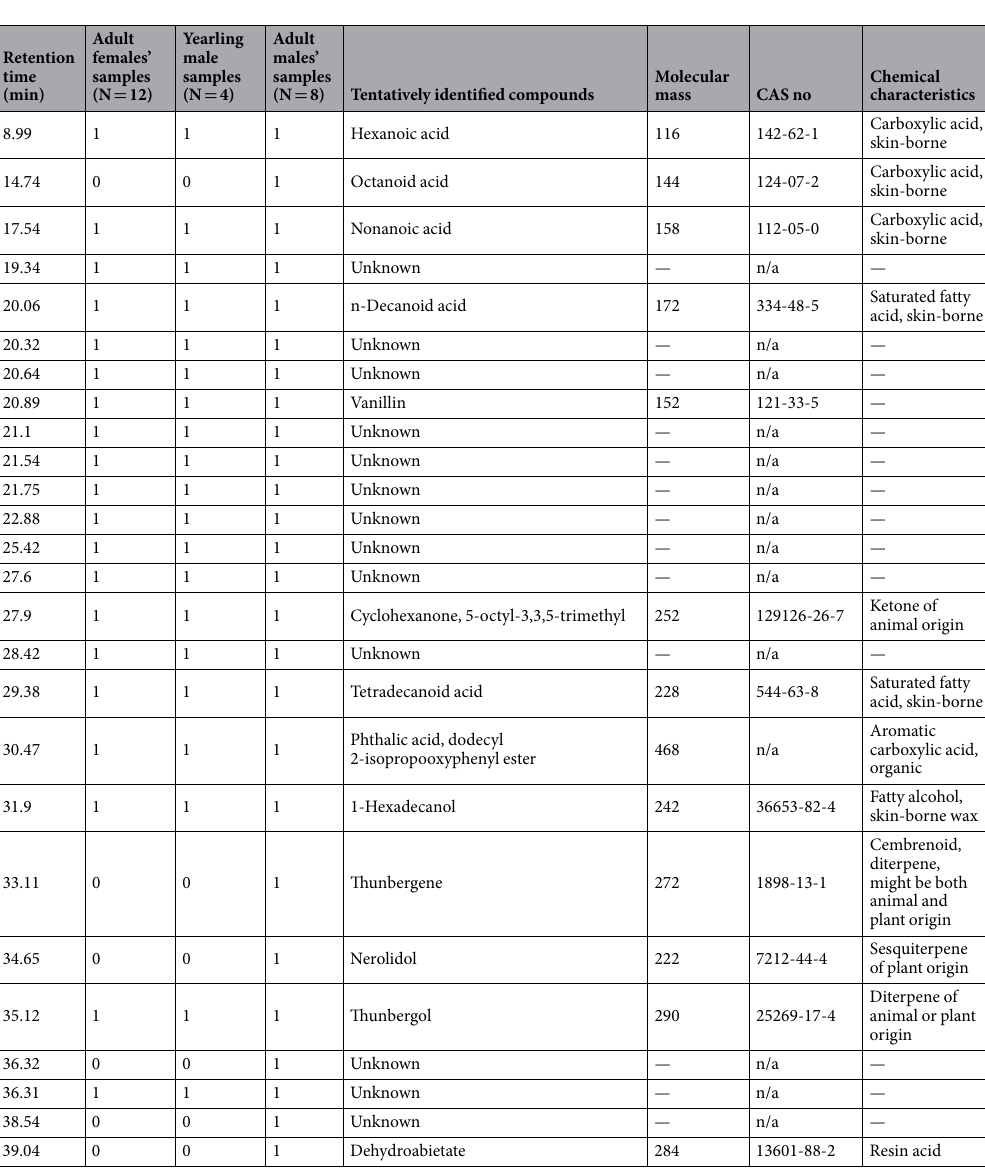
Table 1. Retention times and molecular masses of compounds tentatively identified in pedal swabs of brown bear ( Ursus arctos ; 1 – present in all samples, 0 – absent in all